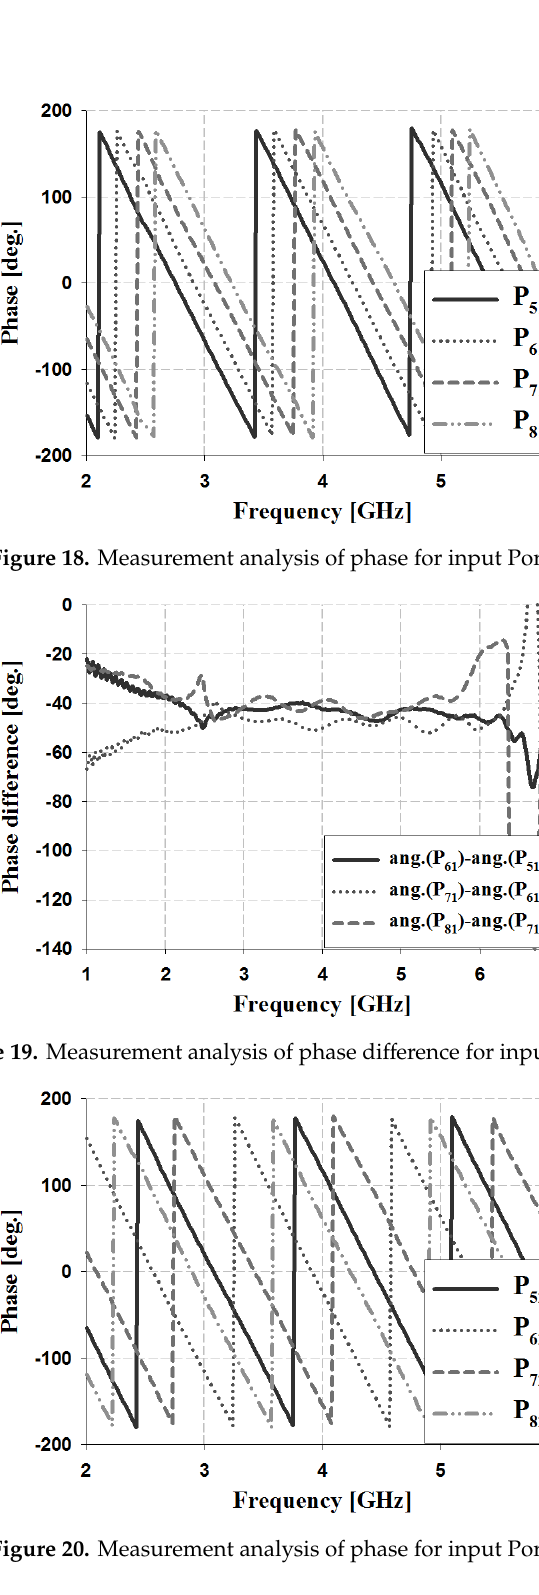
Figure 21. Measurement analysis of phase difference for input Port 2. Table 3. Measurement results of phase difference for 4 × 4 Butler matrix. Output Port Input Port